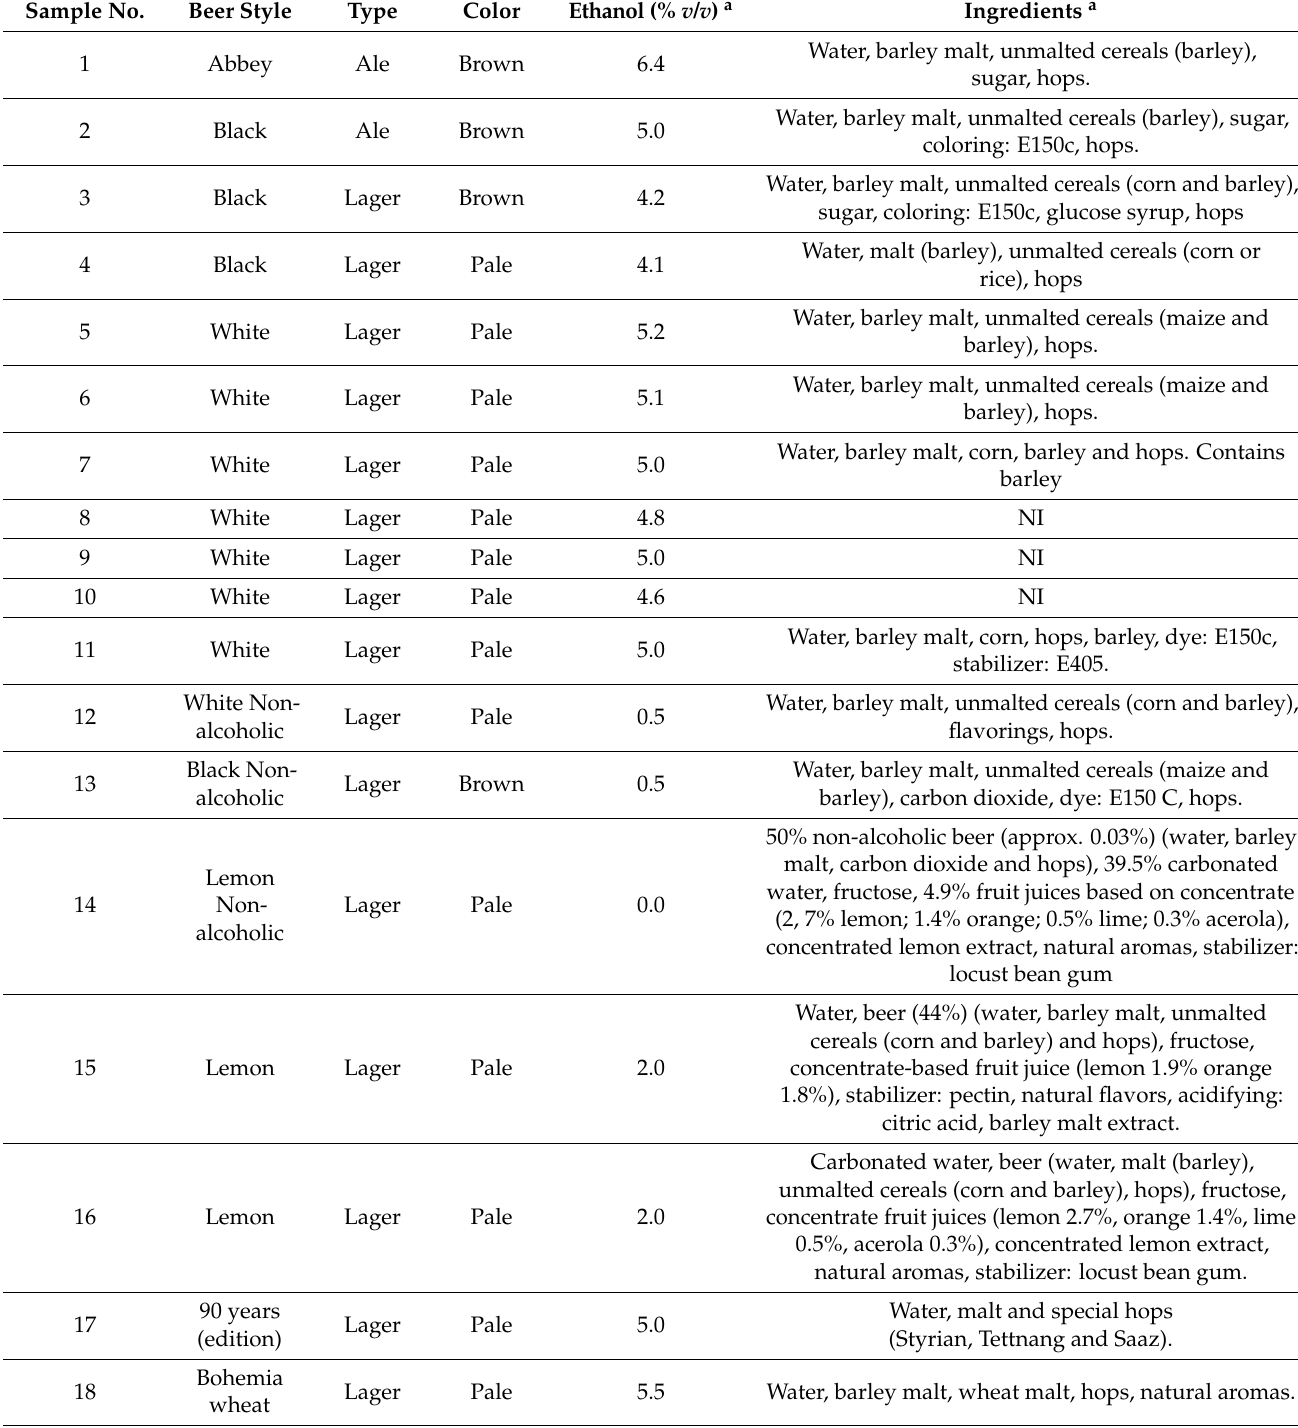
Table 1. Characteristics of Portuguese beers of different types and styles analyzed in this study ( n = 23). Sample